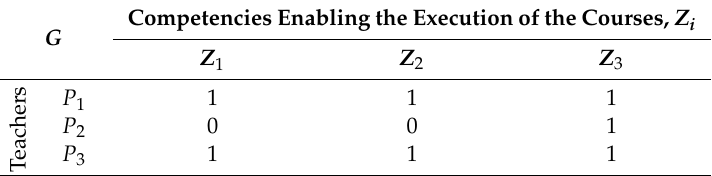
Table 3. Competency framework, G